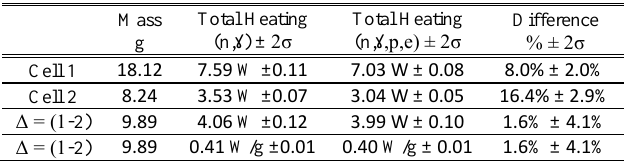
Fig. 11. Detailed geometry of the graphite-based double differential dosimeter. T ABLE IV TRIPOLI-4® SIMULATIONS OF NUCLEAR HEATING ( PROMPT GAMMA EMISSION ONLY ) MEASURED BY A GRAPHITE - BASED DOUBLE - DIFFERENTIAL CALORIMETER INSERTED AT THE IRRADIATION POSITION OF IRMA TEST DEVICE IN